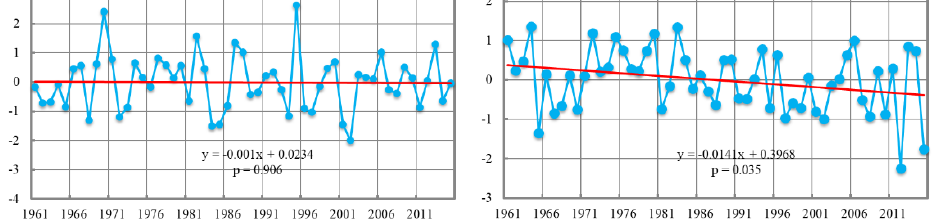
Figure 5. The first four principal components of the corresponding eigenvectors of the EOF analysis.